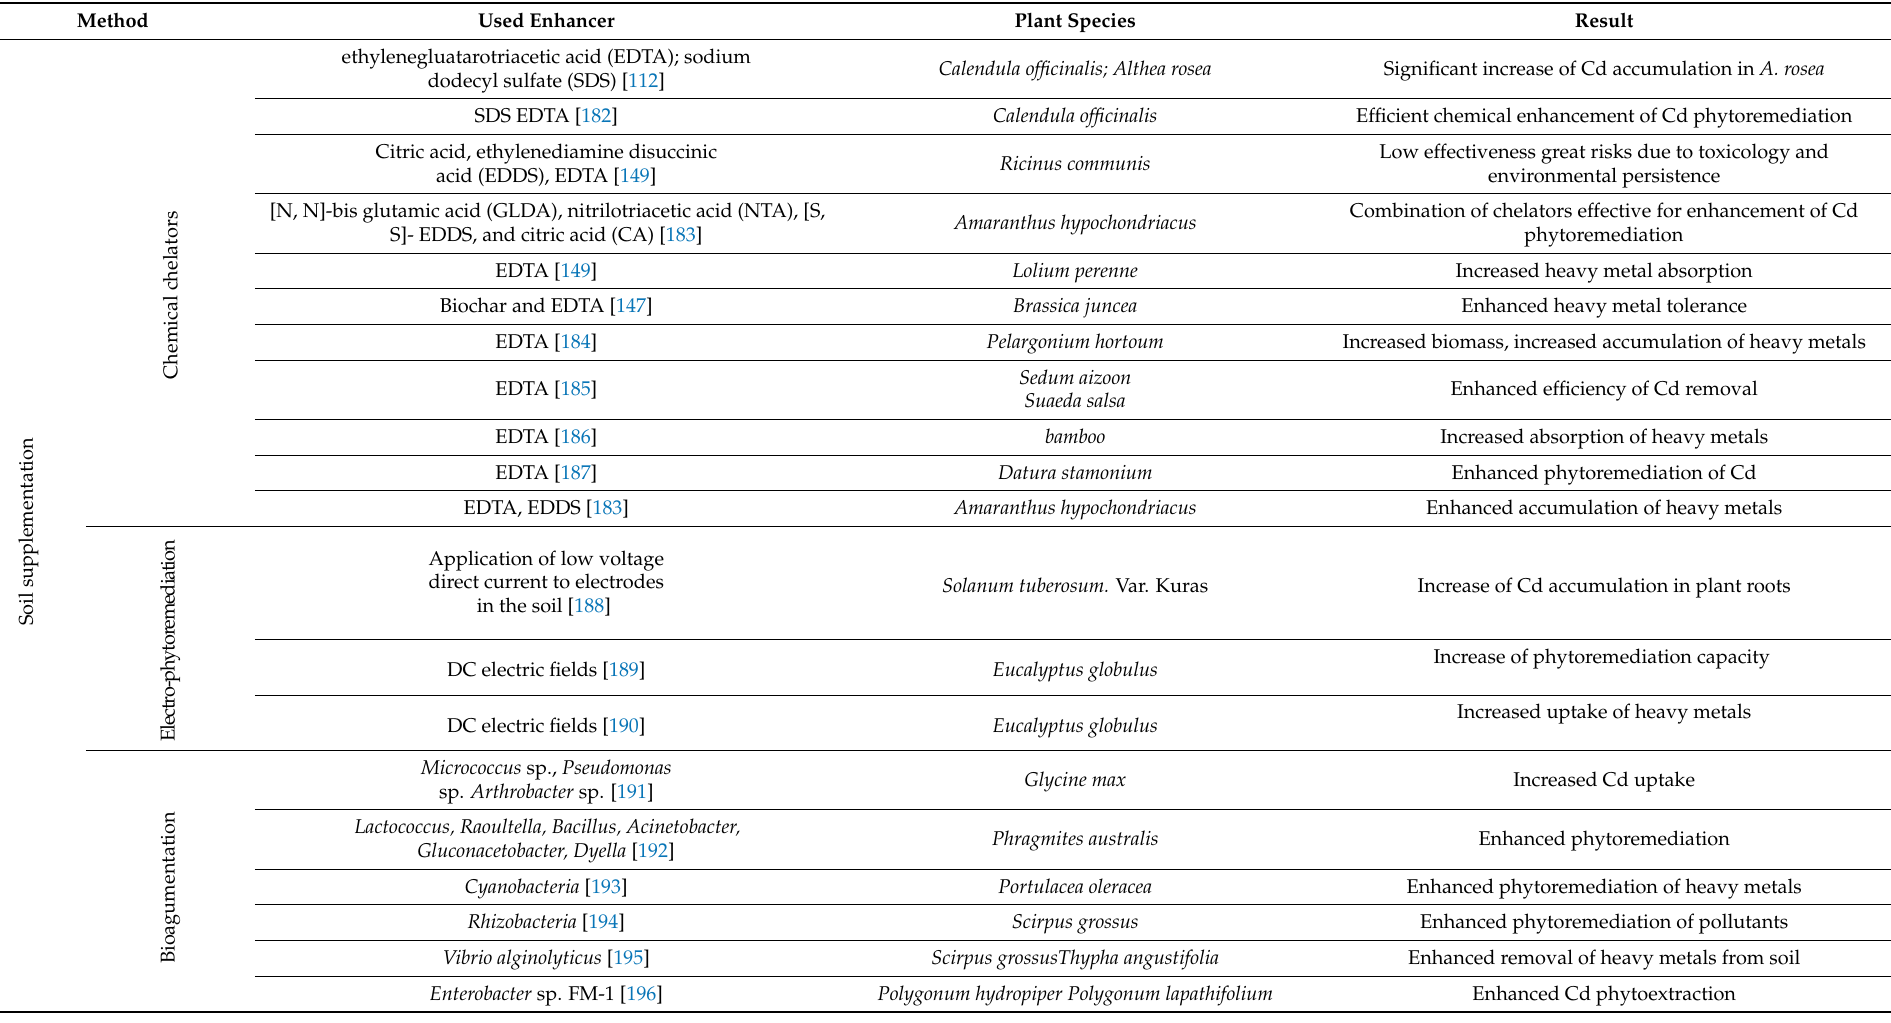
Table 2. Some examples of phytoremediation enhancement